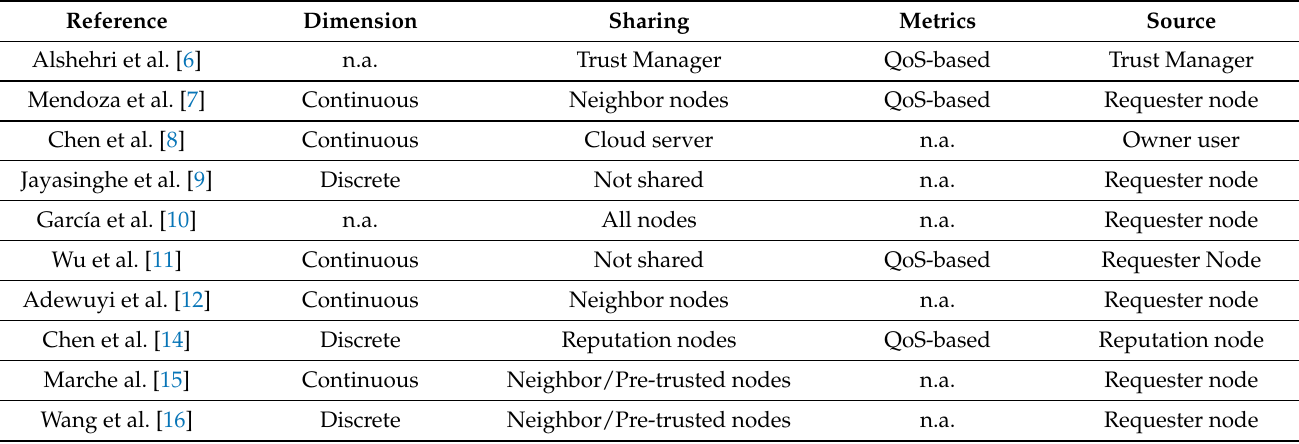
Table 1. Comparison of trust management models: main aspects of the